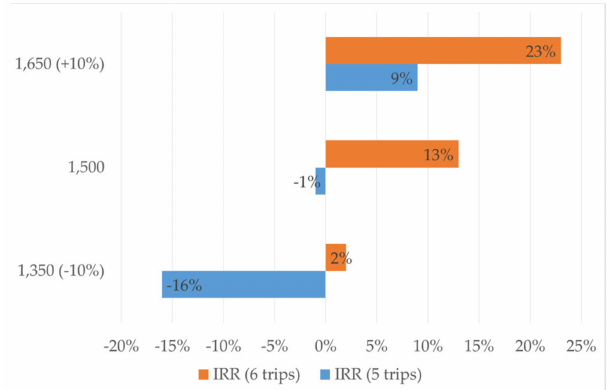
Figure 4. Impact of emptying fee on internal rate of return